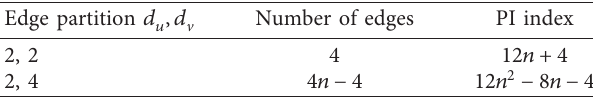
Table 20: Edge partition of para chain of n order.